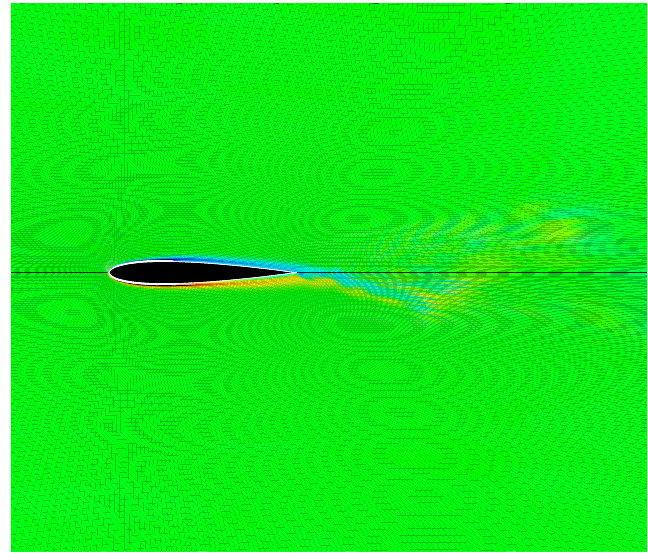
Figure 8. Periodic variation of the thrust coefficient of a heaving and pitching NACA0010